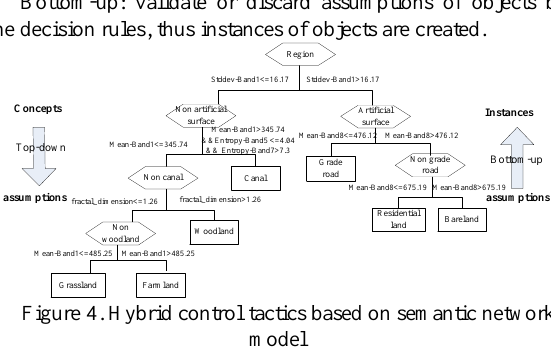
Figure 4. Hybrid control tactics based on semantic network